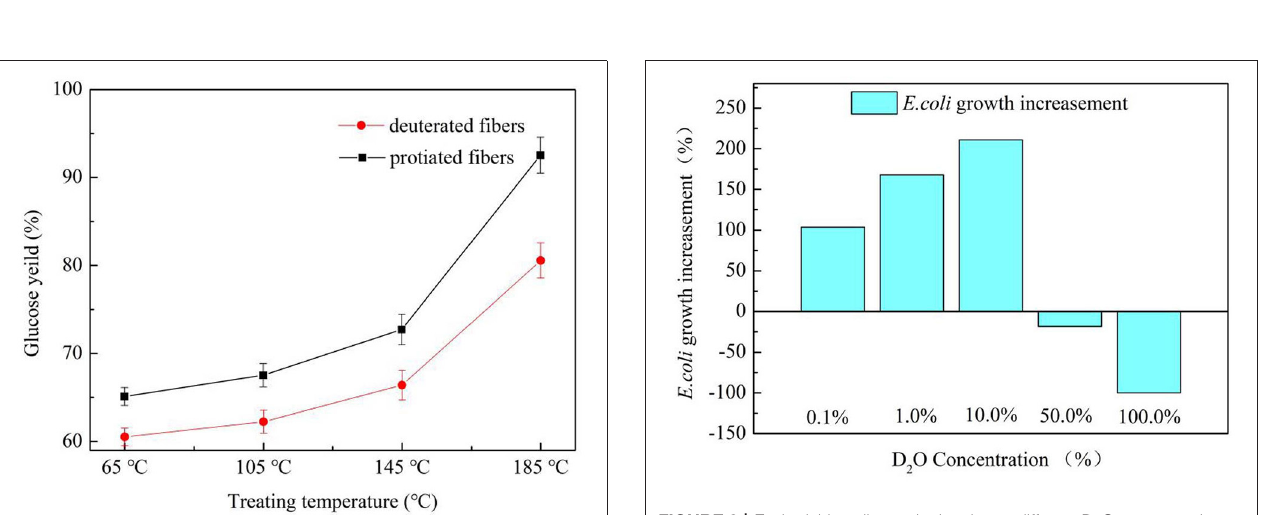
FIGURE 3 | Escherichia coli growth situation at different D 2 O concentration